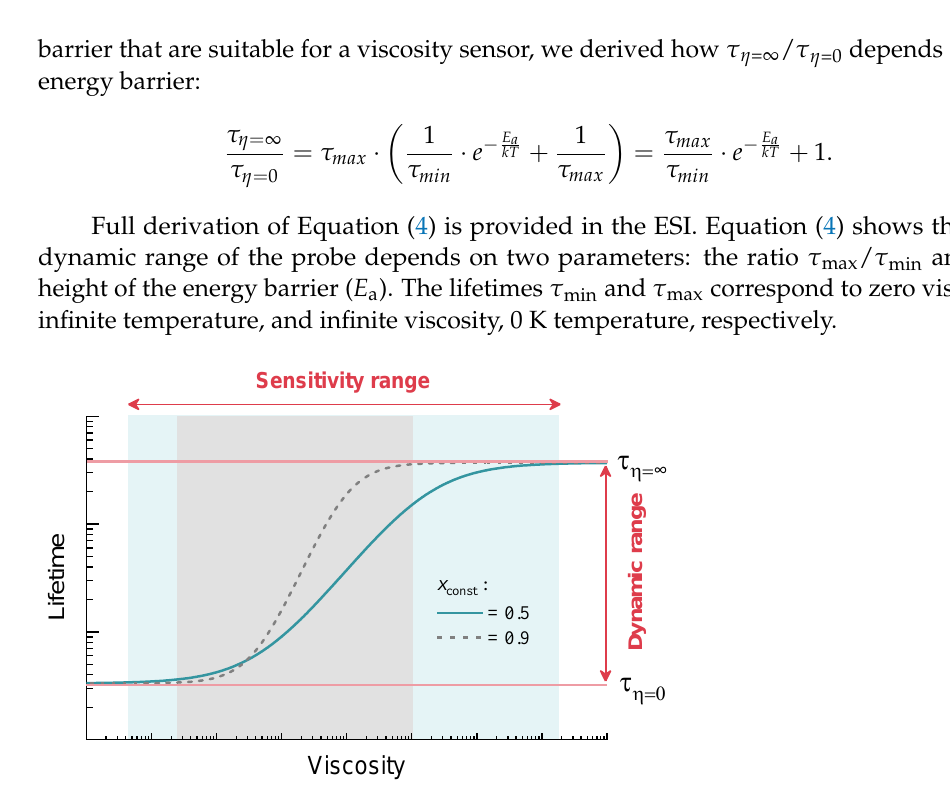
Figure 6. Fluorescence lifetime as a function of viscosity when the Förster–Hoffmann constant x = 0.5 (solid blue line) is at room temperature. If x is increased ( x = 0.9, dashed grey line), the viscosity sensitivity becomes greater but the sensitivity range is decreased. Red lines indicate lifetime limits when the viscosity is 0 (bottom line, τ η =0 ) and infinity (top line, τ η = ∞